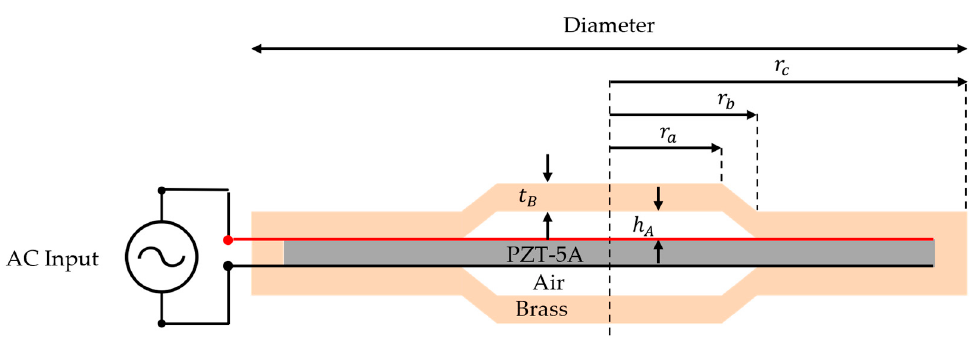
Figure 3. Schematic of cymbal transducer.